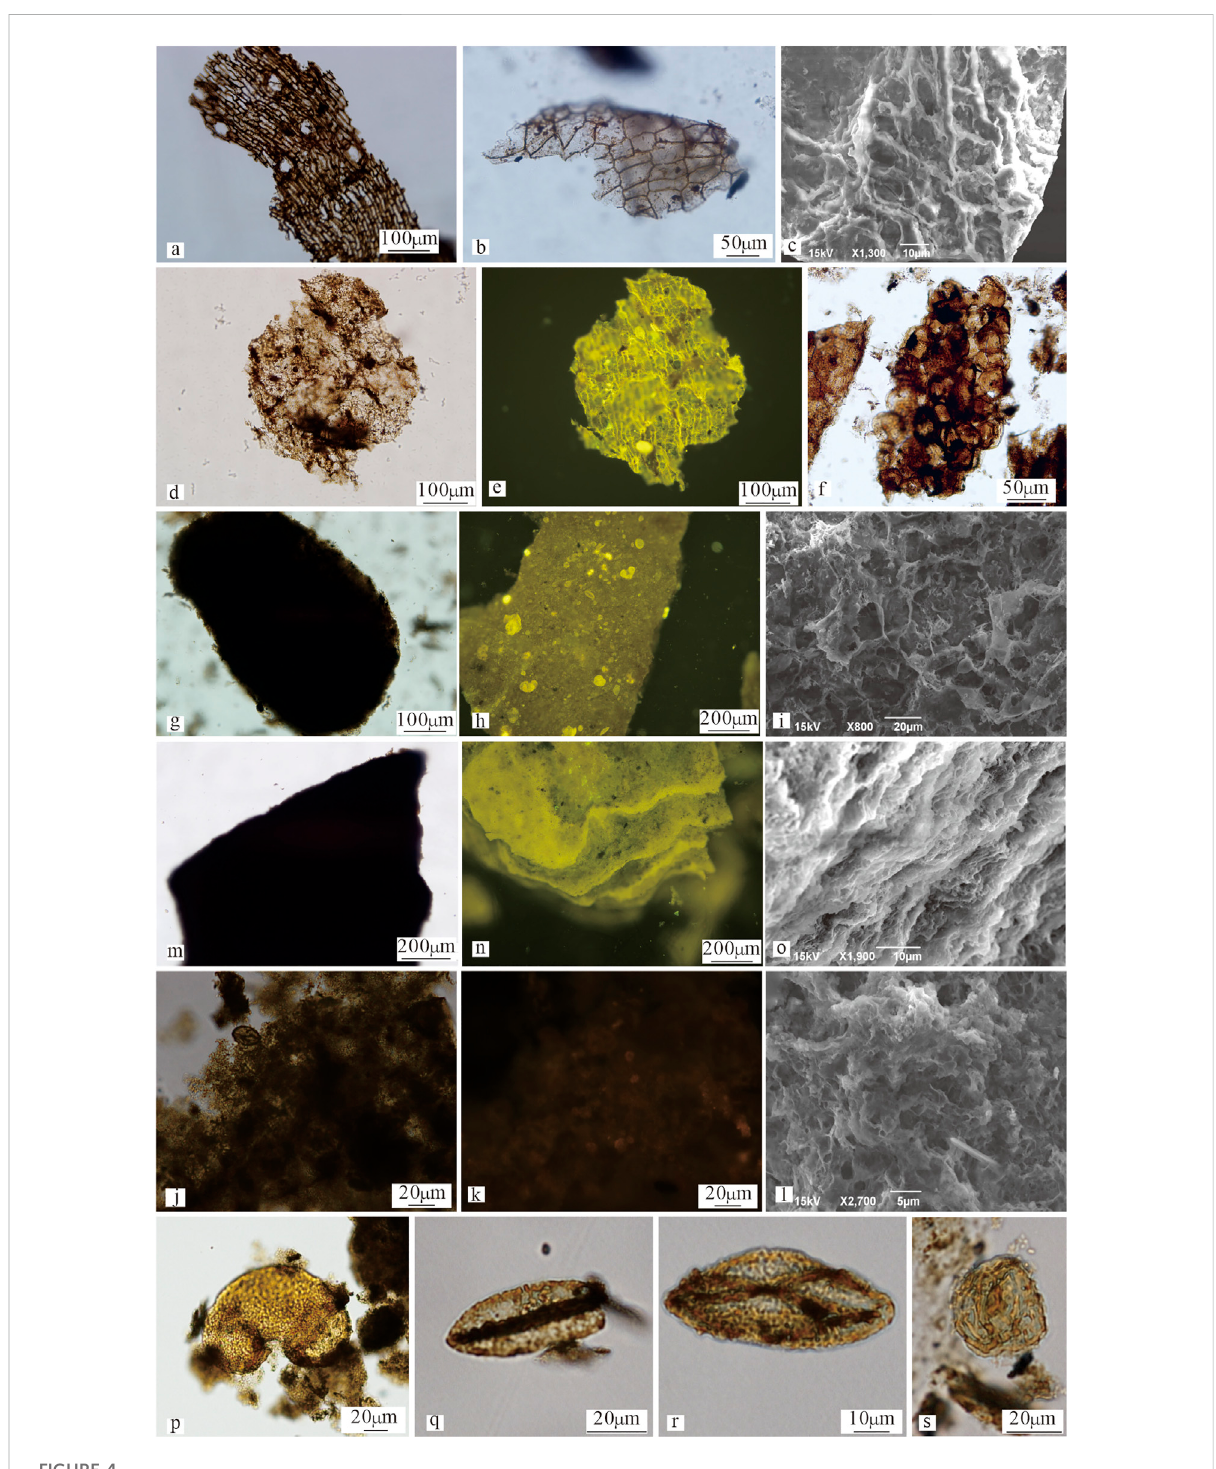
FIGURE 4 Morphological characteristics of each kind of OM. (A,B) . Land plant fragments under transmitted light; (C) . cell structure of land plant tissues under SEM; (D) . macrophyte fragments under transmitted light; ( E ) . macrophyte fragments with good fl uorescence intensity; (F) . tetrasporangia of macrophytes; (G) .; granular AOM under transmitted light; (H) . granular AOM under fl uorescence; (I) . surface of granular OM; (J) . spongy AOM under transmitted light; (K) . spongy AOM with weak fl uorescence intensity; (L) . vesicular extracellularpolymers on thesurfacesof spongy AOM under SEM; (M) . laminated AOM under transmitted light; (N) . laminated AOM under fl uorescent light; (O) . edges of laminated AOM under SEM; (P) . A. microalatus ; (Q) . Ephedripites fushunensis ; (R) . Cupuliferoipollenites sp; (S) . Dictyotidium